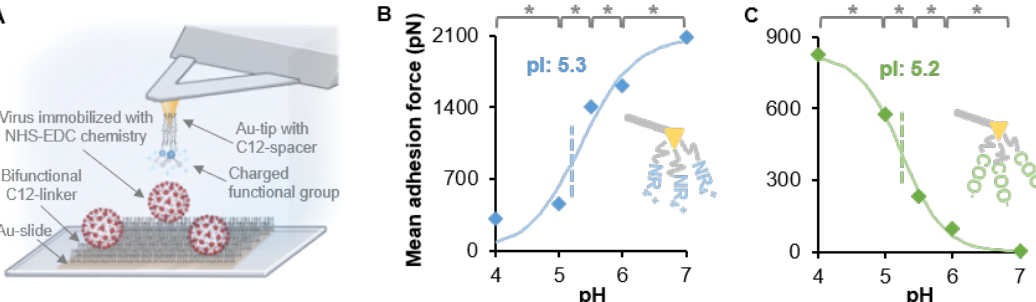
Figure 1. Isoelectric point determination using CFM. ( A ) Inactivated SARS-CoV-2 particles were covalently immobilized on a Au-coated slide that contained a self-assembled monolayer that presented COOH and CH 3 functional groups. NHS/EDC chemistry covalently bound the virus to the COOH groups [16,17]. Au tips were functionalized to provide either negatively charged carboxyl (COO − ) or positively charged quaternary amine (NR 4+ ) groups. Changes in the mean adhesion forces were measured with respect to pH with ( B ) a NR 4 + probe or ( C ) a COO − probe. The data points of the mean adhesion force vs. pH were fit to a sigmoidal curve and the IEP was determined to be the infection point. Each data point represents 450 force curves and the histogram for each individual point can be found in Figure S2. * p < 0.05 from student’s t -test. Image A was made with